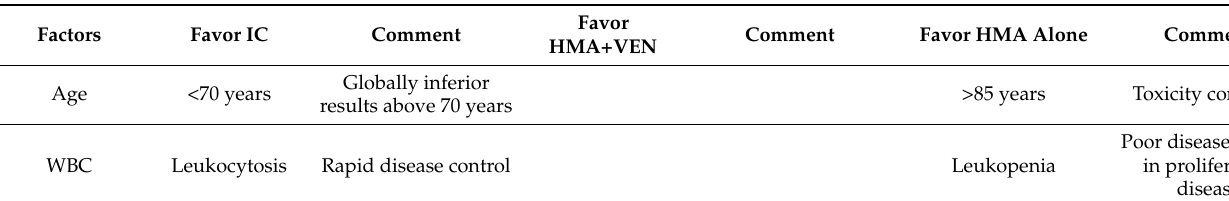
Table 5. Genetic and clinical factors considered when choosing between hypomethylating agents alone, hypomethylating agents in combination with venetoclax and intensive